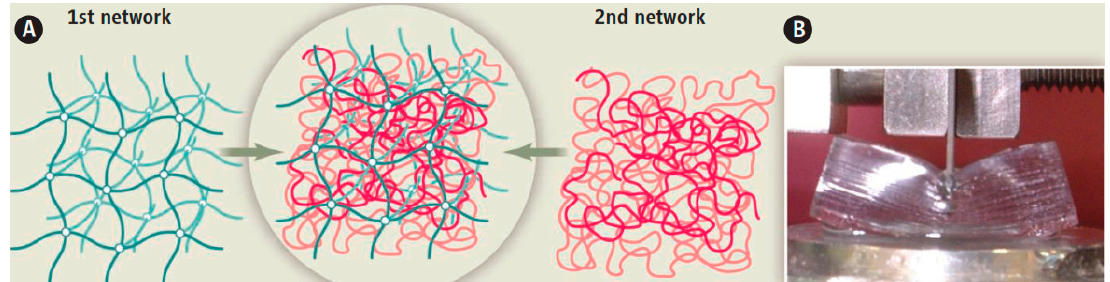
Figure 1. ( Α ) Schematic representation of a double-network (DN) hydrogel prepared from the combination of two different polymer networks. ( Β ) Photograph of a tough DN hydrogel containing 90 wt% water. Adapted and reprinted with permission from [11]. Copyright 2014 American Association for the Advancement of Science.